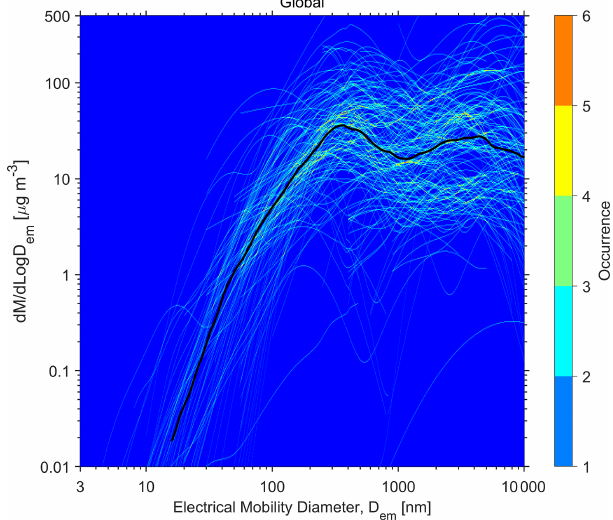
Figure 9. Urban aerosol mass PSDs analyzed in this study from around the globe (122 PSDs). The figure incorporates mass PSDs measured by gravimetric methods with inertial im- pactors and measurements made with electrical mobility-based and aerodynamic-/optical-based techniques that cover both the submi- cron and coarse mode. The color represents the occurrence fre- quency of the mass PSDs at a given particle size with a certain concentration. The black line indicates the median mass